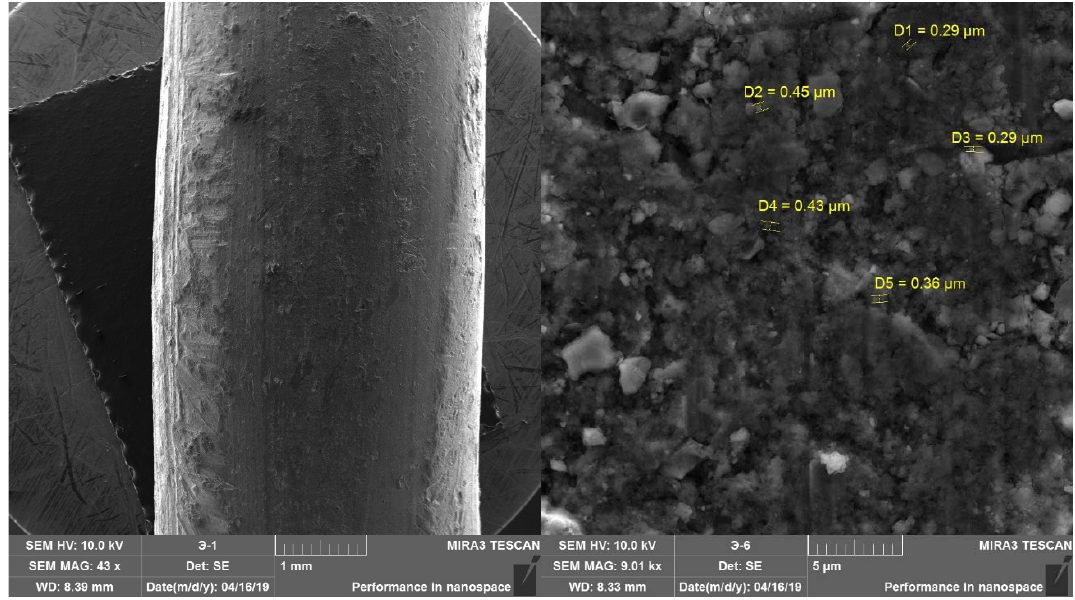
Figure 10. Micrography of the SEM surface of metallic aluminum.